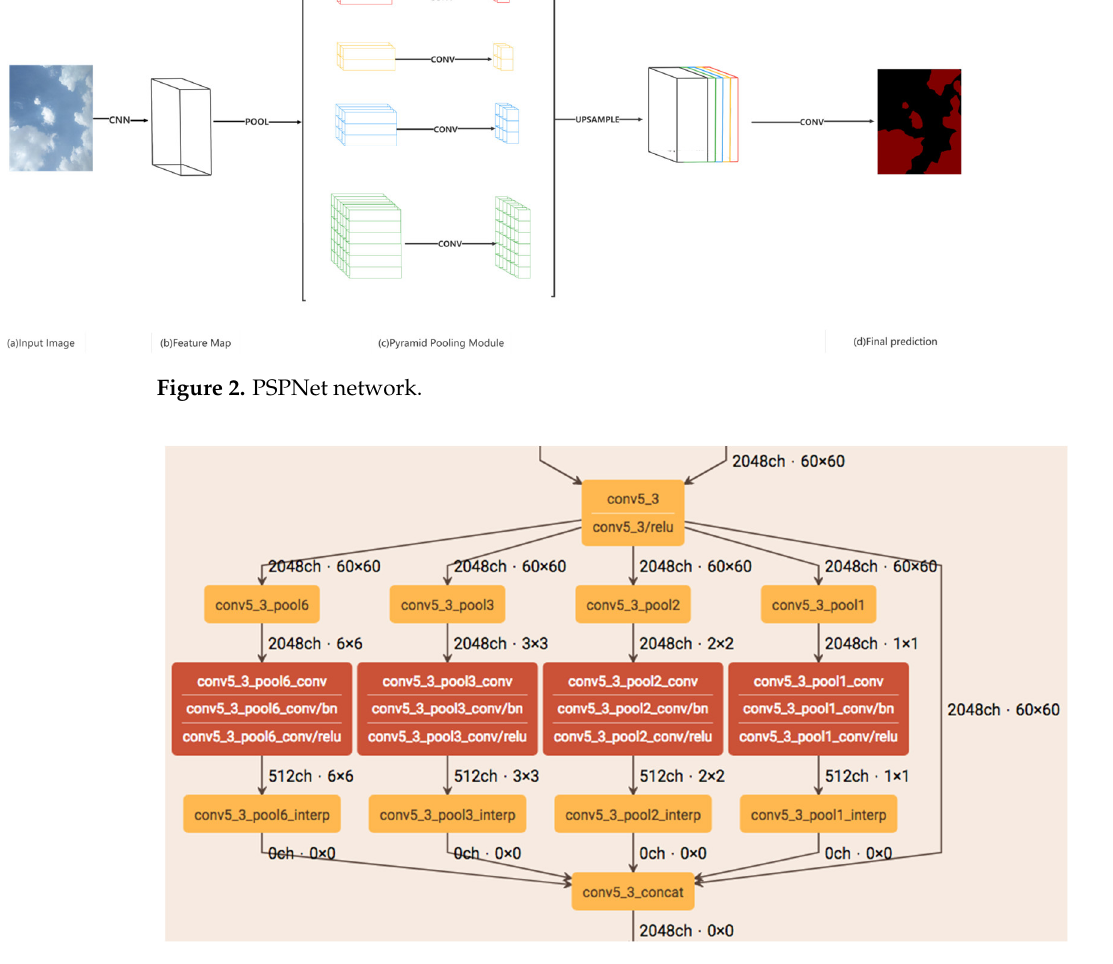
Figure 3. Netscope space pyramid pool structure.